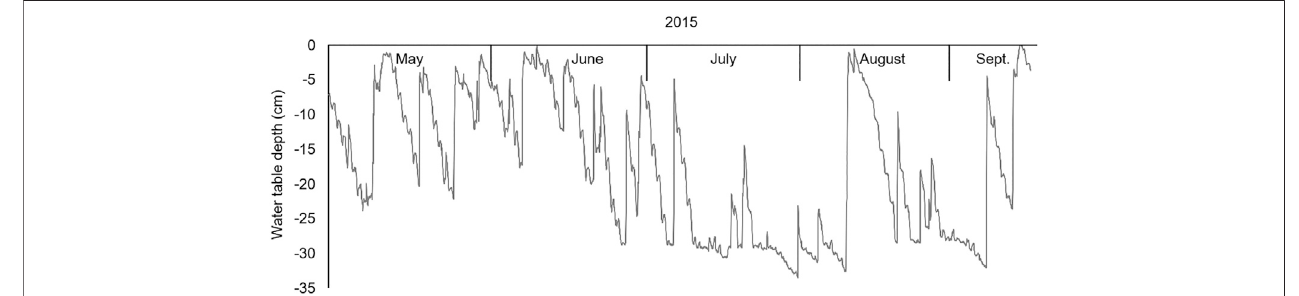
FIGURE 1 | Water table depth at Sainte-Eulalie in